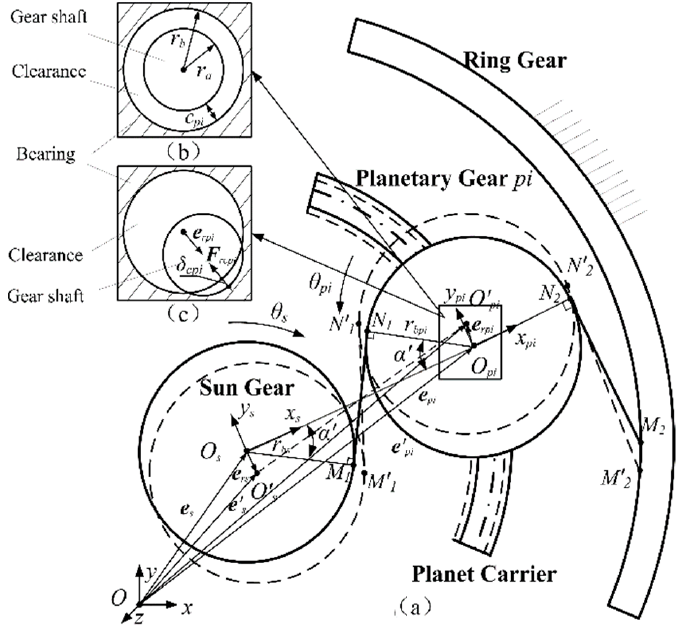
Figure 2. ( a ) Schematic representation of a planetary gear pair with clearance (clearance exaggerated for clarity); ( b ) gear pair with radial clearance and free movement; and ( c ) penetration depth between the gear shaft and bearing during impact.